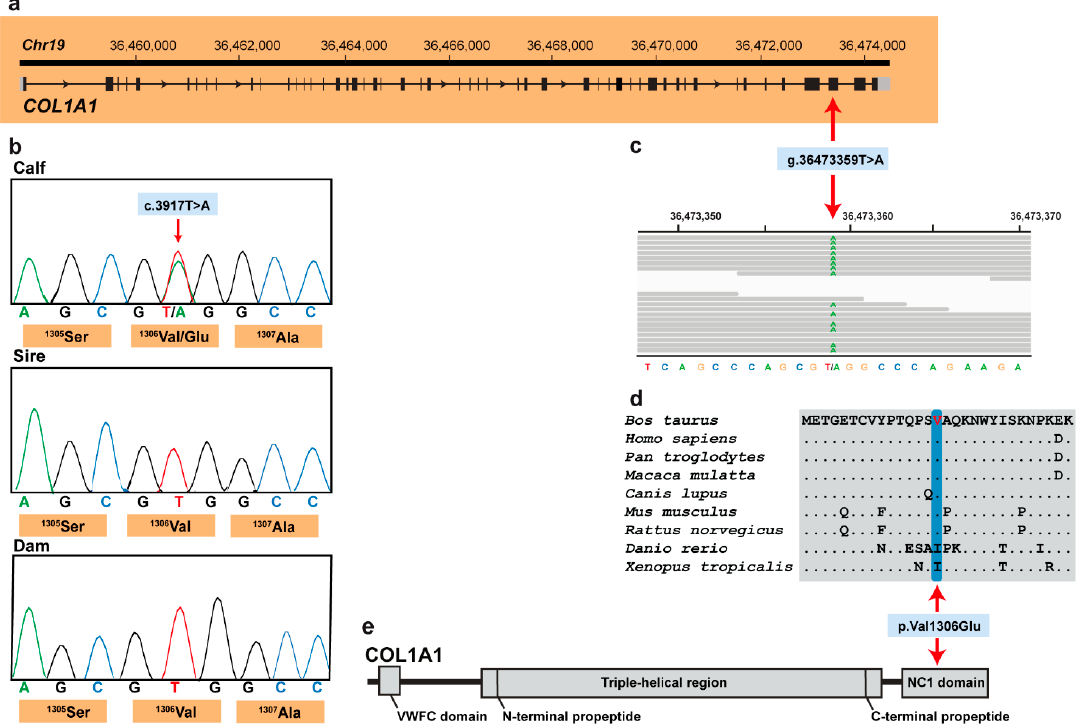
Figure 3. COL1A1 missense variant in an OI type II-affected Holstein calf. ( a ) COL1A1 gene structure showing the variant location on chromosome 19, exon 49 (red arrow); ( b ) Electropherograms showing the heterozygous genotype of the calf, and the absence of the variant in its dam genome and in the germline of its sire. ( c ) IGV screenshot presenting the Chr19: g.36473359T>A variant in the affected calf. ( d ) Multiple sequence alignment of the collagen alpha-1(I) chain of the COL1A1 protein encompassing the region of the p.Val1306Glu variant demonstrates complete evolutionary conservation across species. ( e ) Schematic representation of COL1A1 protein and its three functional domains.